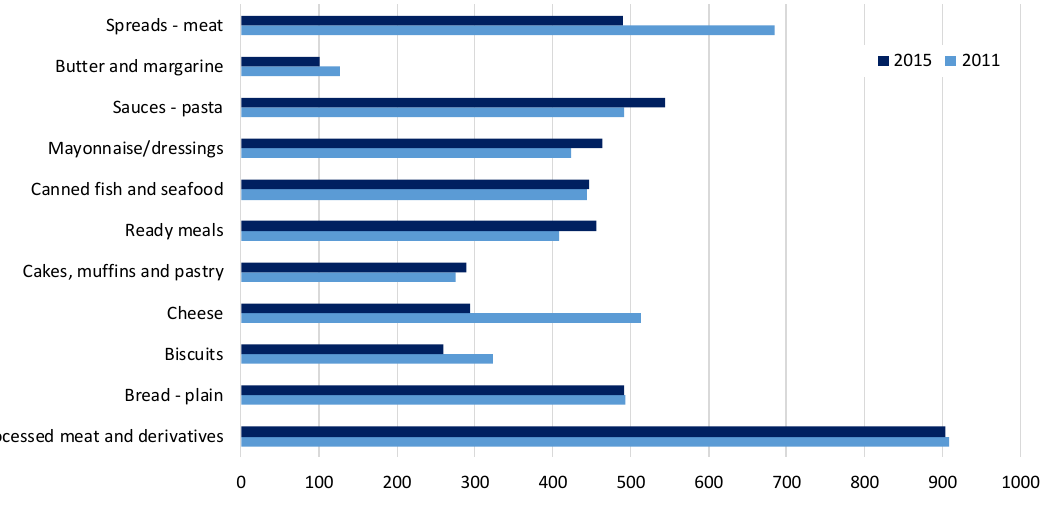
Figure 1. Comparison of the average sodium content of sold (SCS) prepacked foods for selected food (sub)categories (mg/100 g) in 2011 and 2015.